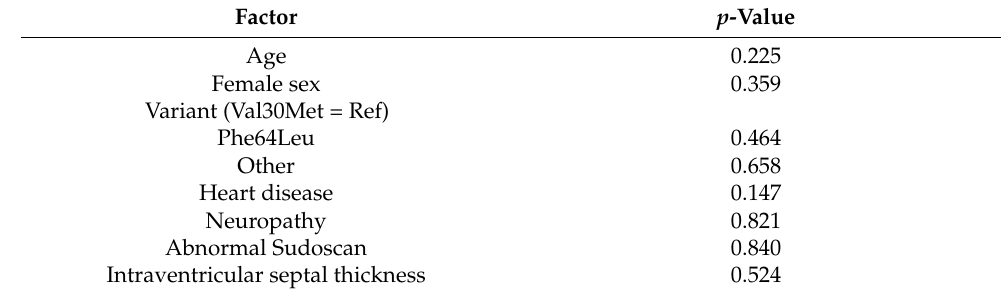
Table 3. Predictors of slope of